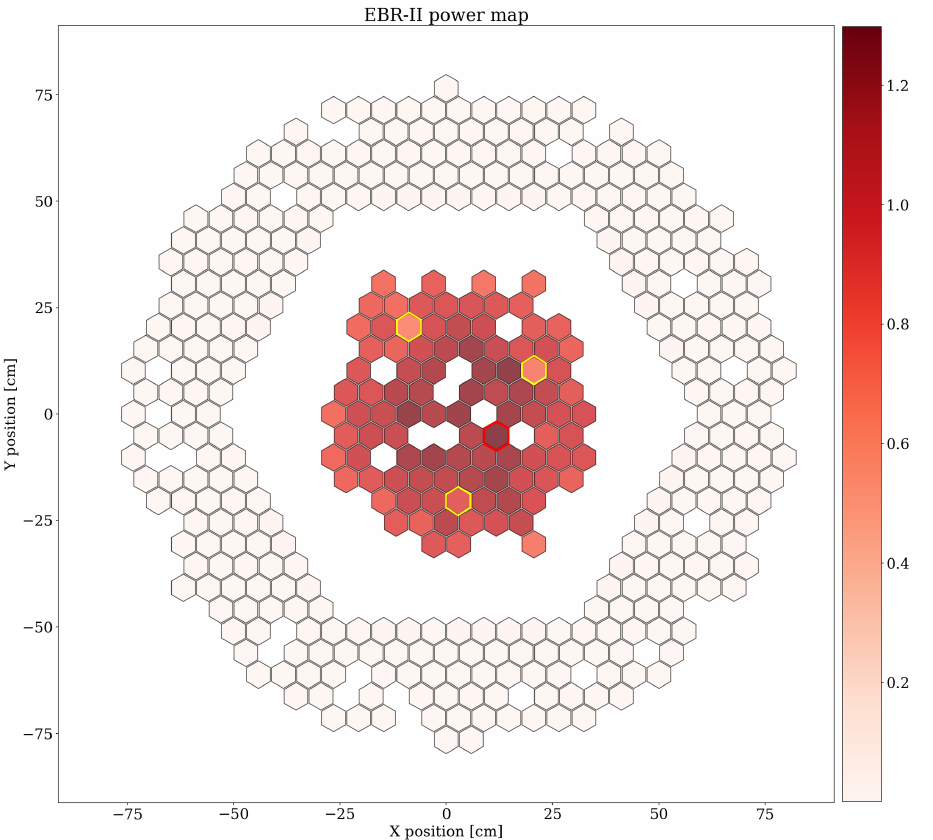
Figure 8. KENO-MG radial power distribution (axially integrated assembly powers) using ENDF/B-VII.1 data. High power is visible in the central driver core region, whereas only very low power is observed in the outer blanket region. The power was normalized to yield an average inner driver assembly power of